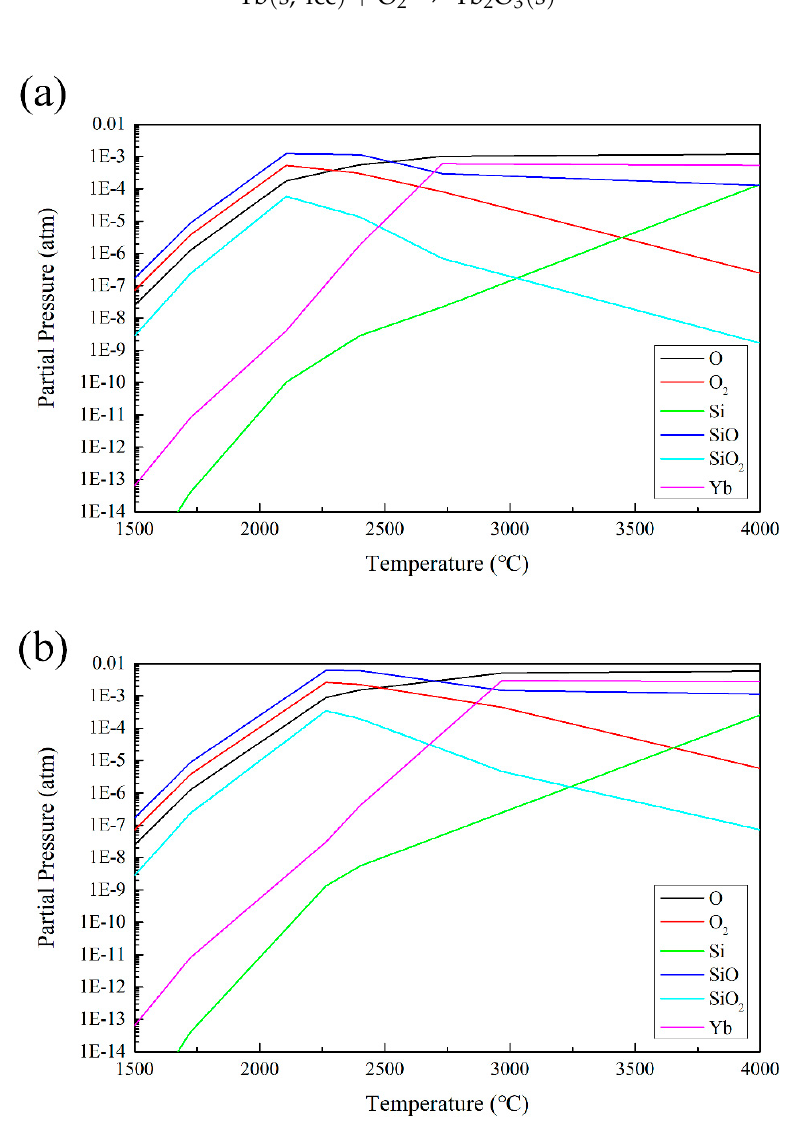
Figure 13. Calculated partial pressure versus temperature plot for primary gaseous species in the Yb–Si–O system in ( a ) 2 mbar and ( b ) 10 mbar. Curves are reported for an equilibrated system.